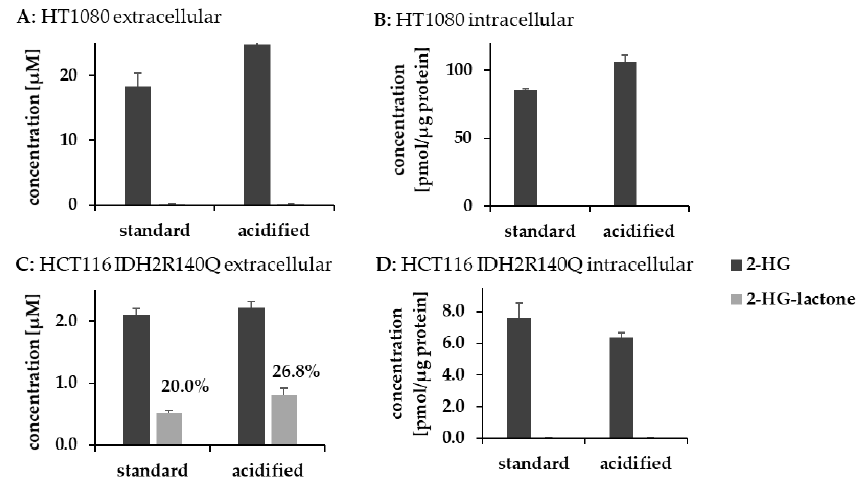
Figure 8. Impact of pH on 2-HG-lactonization in cells. IDH1/2 mutant cells were cultured under acidified conditions to investigate the impact of pH on 2-HG lactonization. ( A , B ) Extra- and intracellular concentrations of 2-HG and 2-HG-lactone after 6 h for HT1080 cells; ( C , D ) extra- and intracellular concentrations of 2-HG and 2-HG-lactone after 6 h for HCT116 IDH2-R140Q . 2-HG-lactone was below the LLOQ in cell extracts. (n = 2–3; error bars indicate SD; and percentages represent amounts of 2-HG-lactone relative to the sum of 2-HG and 2-HG-lactone).